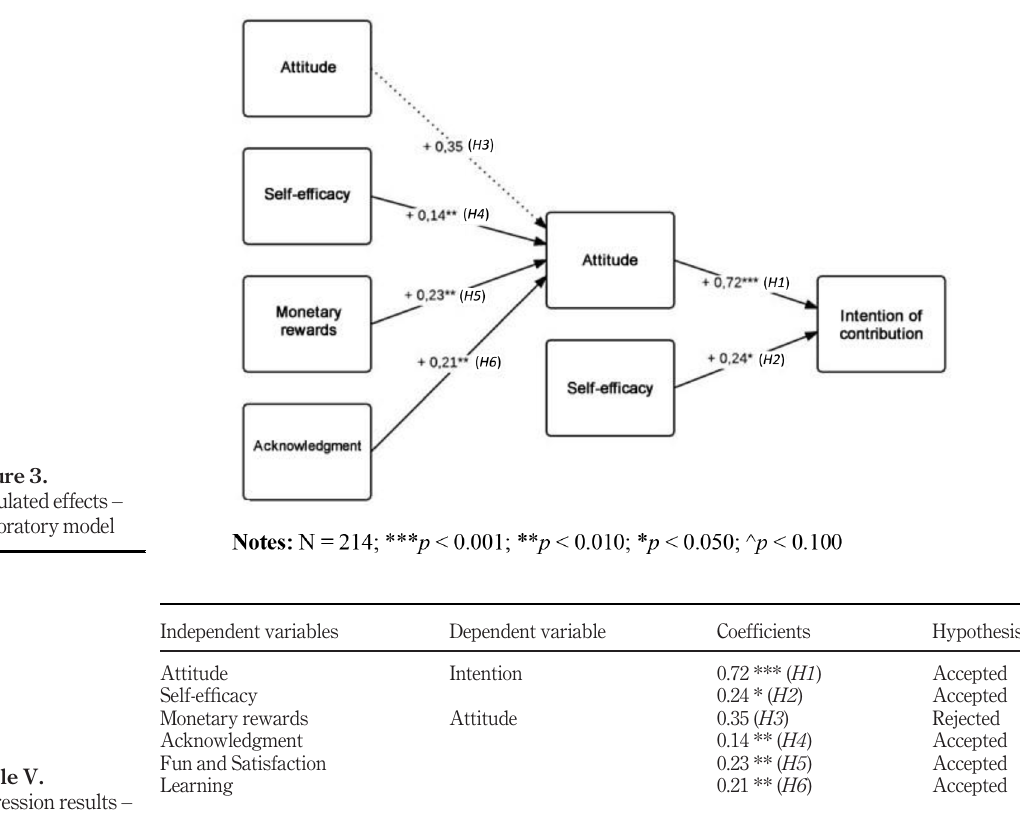
Table V. Regression results – exploratory